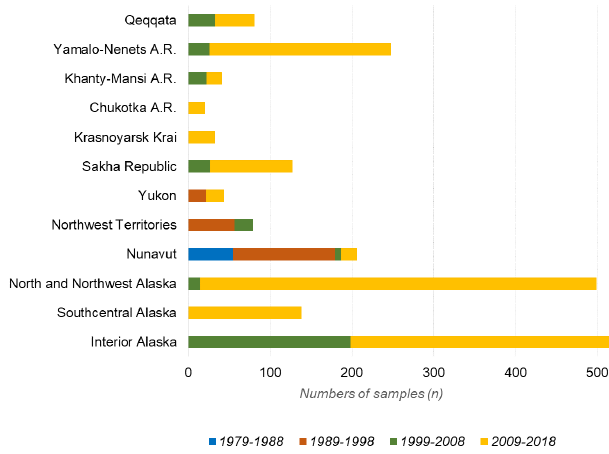
Figure A1. Histogram of numbers of samples in each study area per decade of sample collection. Since an exact allocation of the sampling year was not possible for 113 samples, these are missing in this figure for study areas Nunavut and Manitoba, Canada.